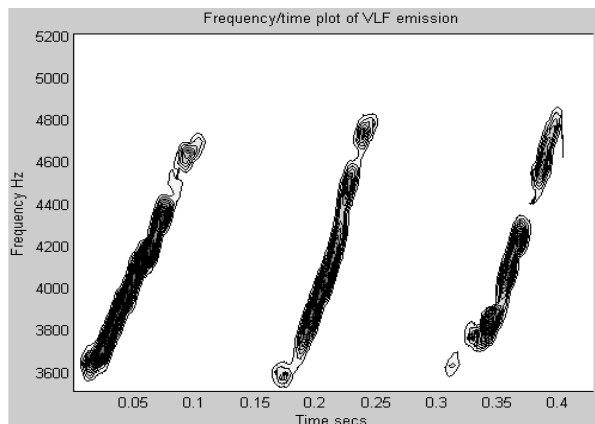
Fig. 6. Spectrogram of the exit wave field data stream for a cold Fig. 6. plasma density of Ne=2 electrons/cc at L =4.4. The saturation am- plitude is 200pT, the initial linear equatorial growth rate 1200dB/s, and the local electron gyrofrequency 10.3kHz. The sweep rate of the chorus elements is